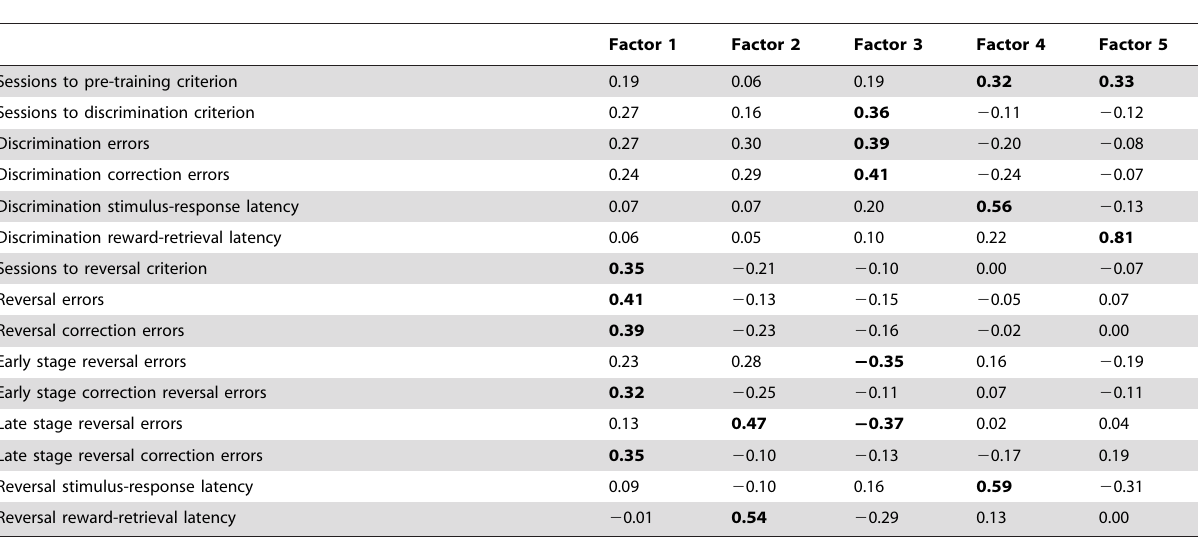
Table 2. Principal components analysis of touchscreen performance and